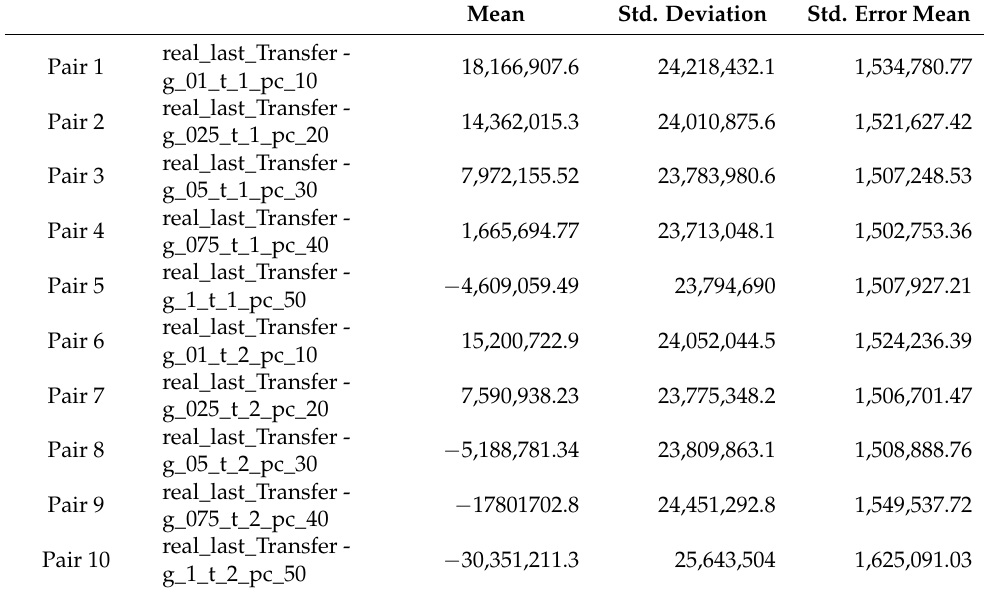
Table 5. Sample comparison test of transfer